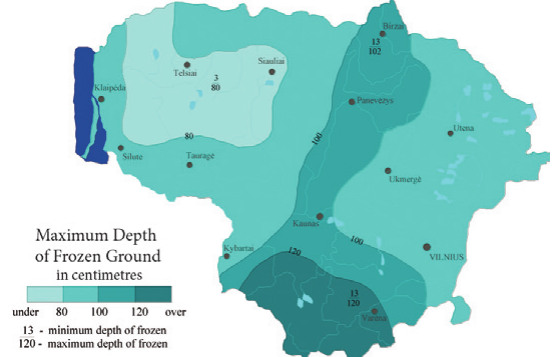
Fig. 1. Map of frozen ground